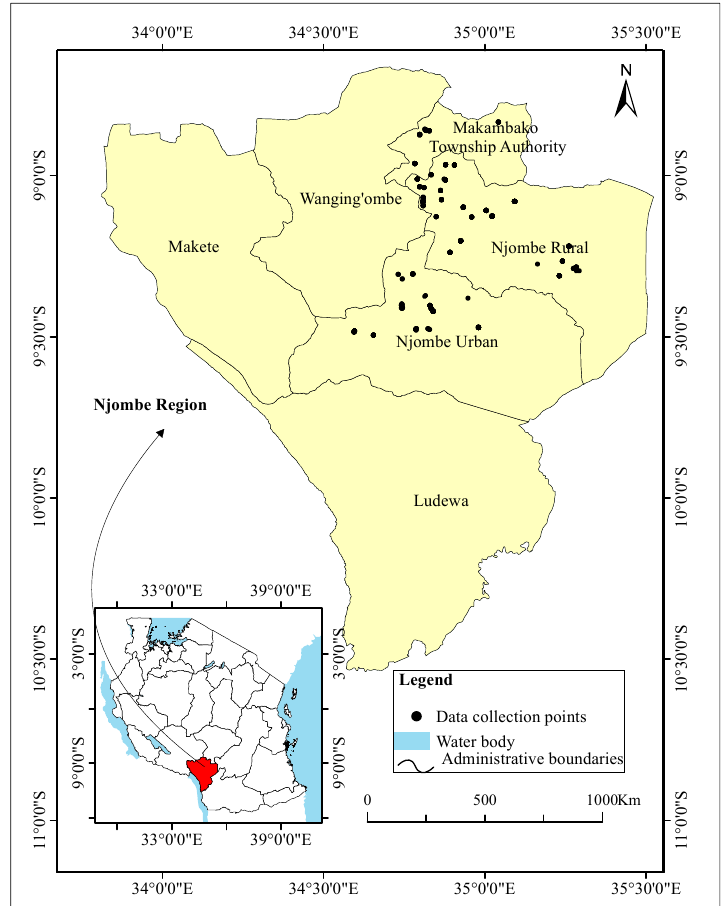
Figure 2. Map of Tanzania showing the study location.